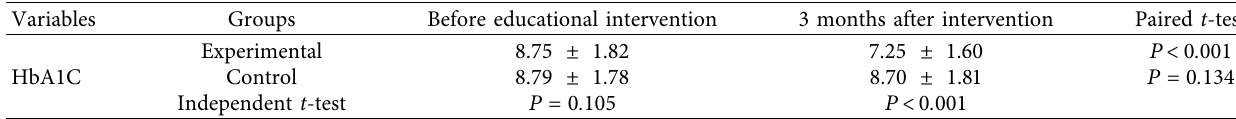
Table 3: Comparison of average values of HbA1c in experimental and control groups before and 3 months after educational intervention. Variables